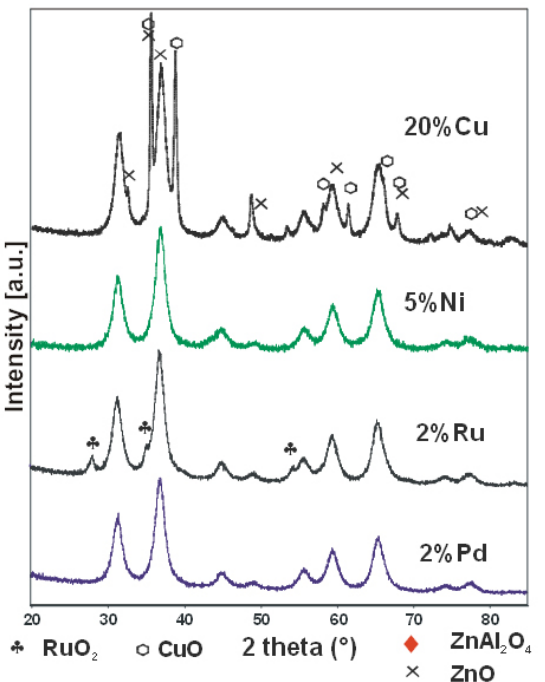
Figure 1. XRD patterns for Cu, Ni, Ru, Pd, catalysts calcined in air at 400°C for 4